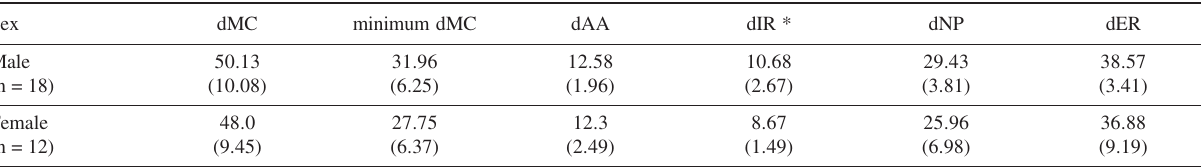
* P < 0.05. dMC = distance between the apex of coracoid process and the point of entry of the musculocutaneous nerve into the coracobrachial muscle minimum dMC = smallest distance between the apex of coracoid process and the musculocutaneous nerve dAA = smallest distance between the apex of coracoid process and the acromial artery dIR =distance between the lesser tubercle of the humerus and the apex of coracoid process as measured at maximum internal rotation of the humerus dNP = distance between the lesser tubercle of the humerus and the apex of coracoid process as measured at neutral position of the humerus dER = distance between the lesser tubercle of the humerus and the apex of coracoid process as measured at maximum external rotation of the Table 3 - Distances (mm) between the apex of coracoid process and the anatomical structures analyzed, stratified by side of body, average (standard deviation)